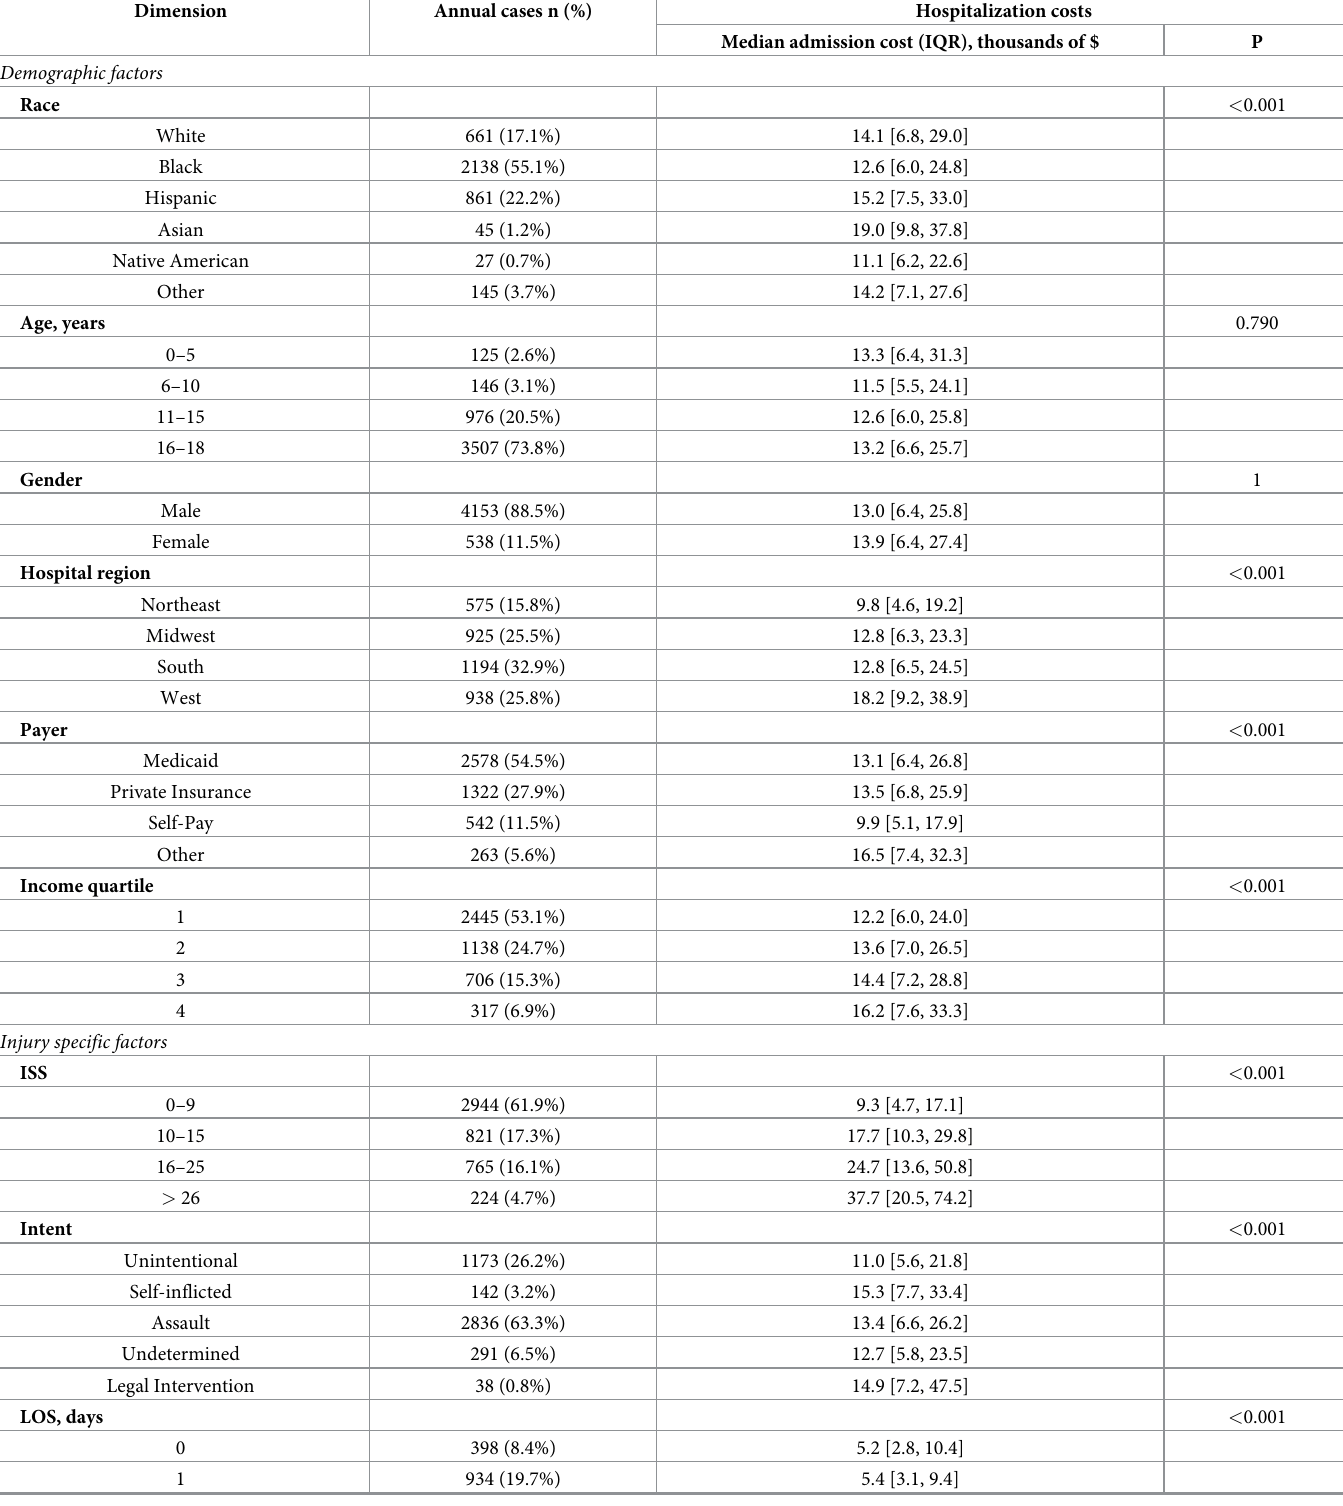
Table 1. Incidence and median cost of pediatric firearm hospitalizations in the U.S. (2003, 2006, 2009,